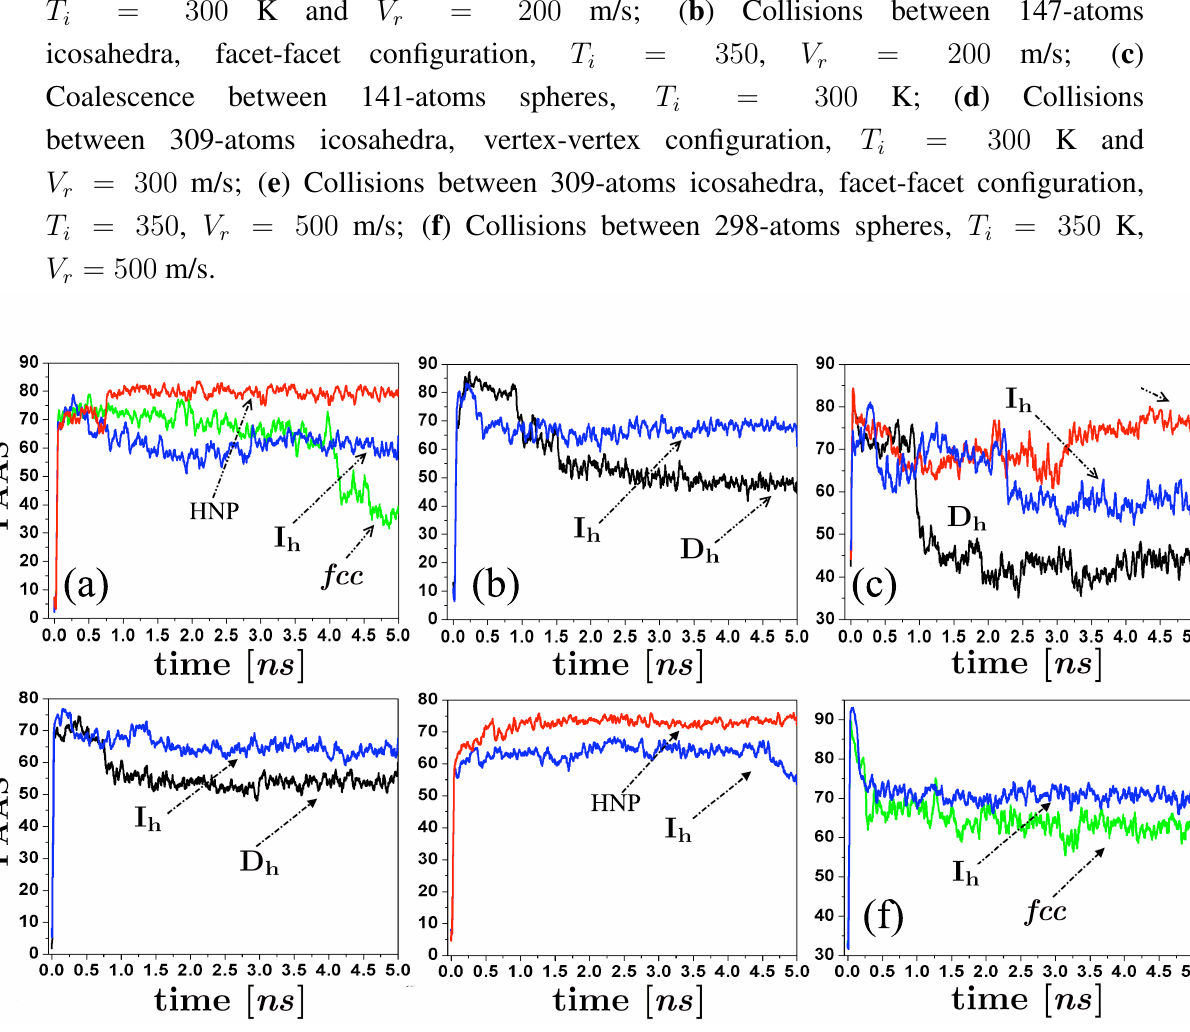
Figure 6. Time evolution of the percentage of atoms in amorphous state along the runs, for some of the structures produced by the simulations ( I (HNP)). ( a ) Collisions between 147-atoms icosahedra,